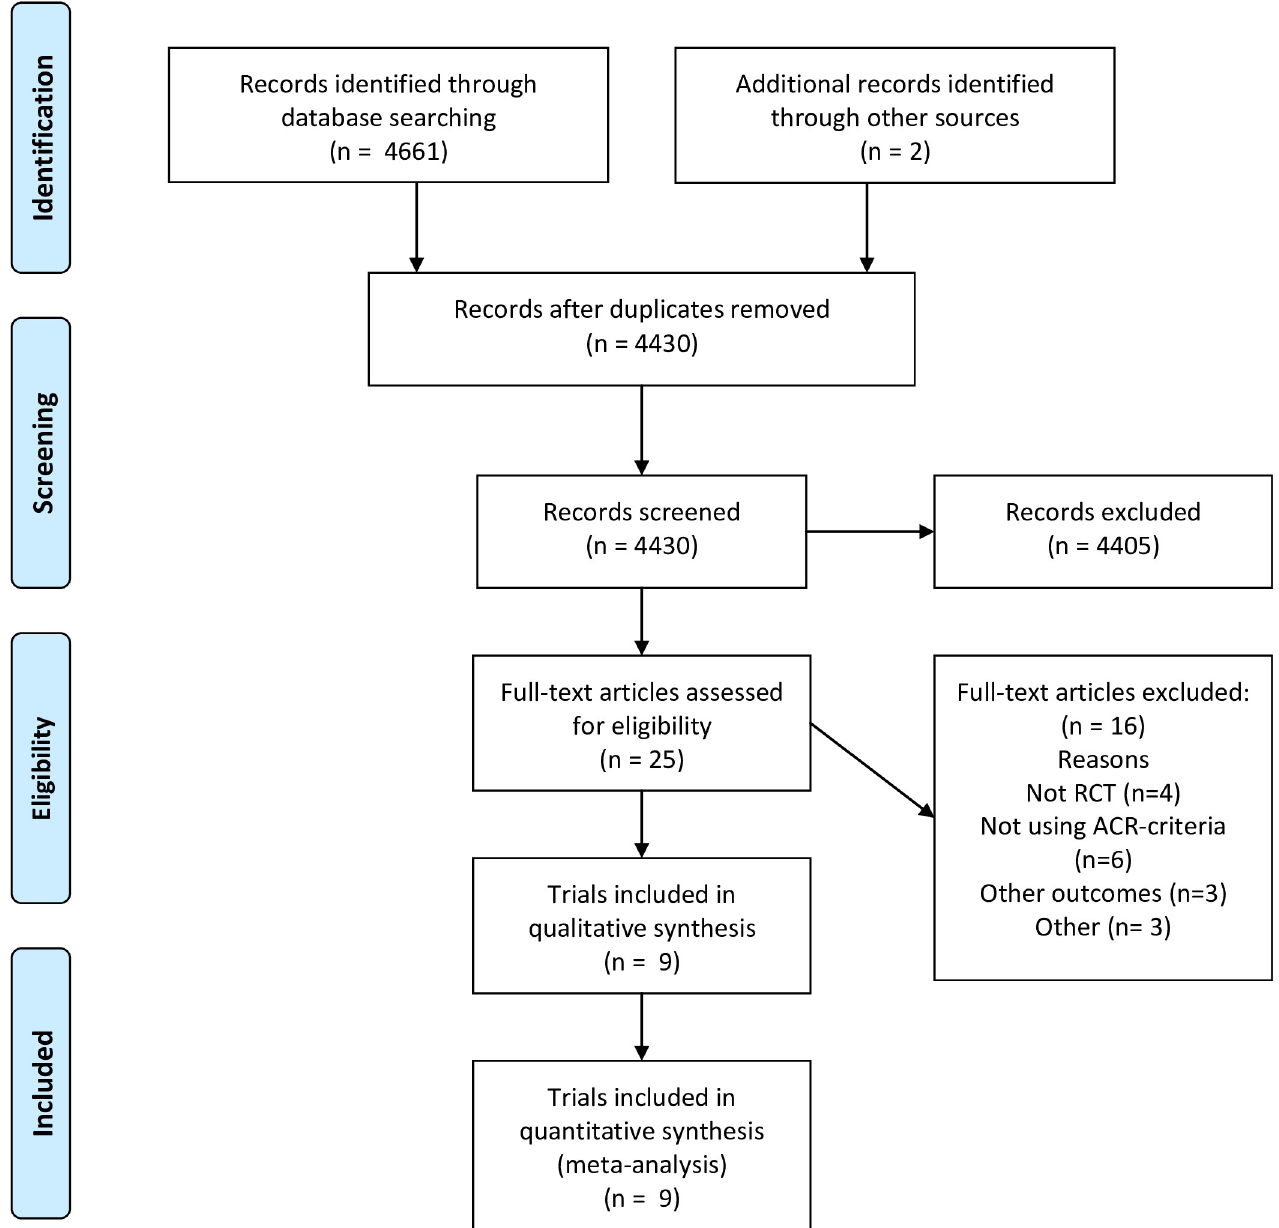
Fig 1. PRISMA flow diagram. PRISMA Study flow diagram.